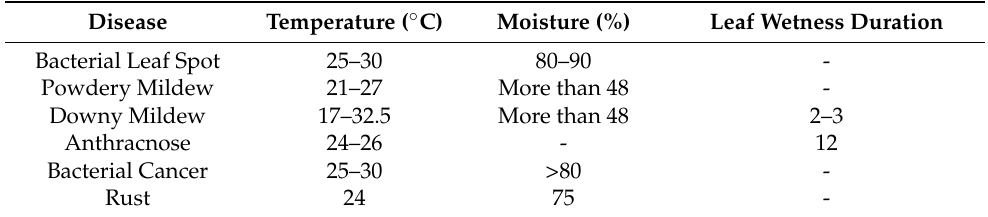
Table 4. Favorable conditions for disease spread in grapevine. Reprinted with permission from ref. [104]. Copyright 2016 Rajarambapu Institute of